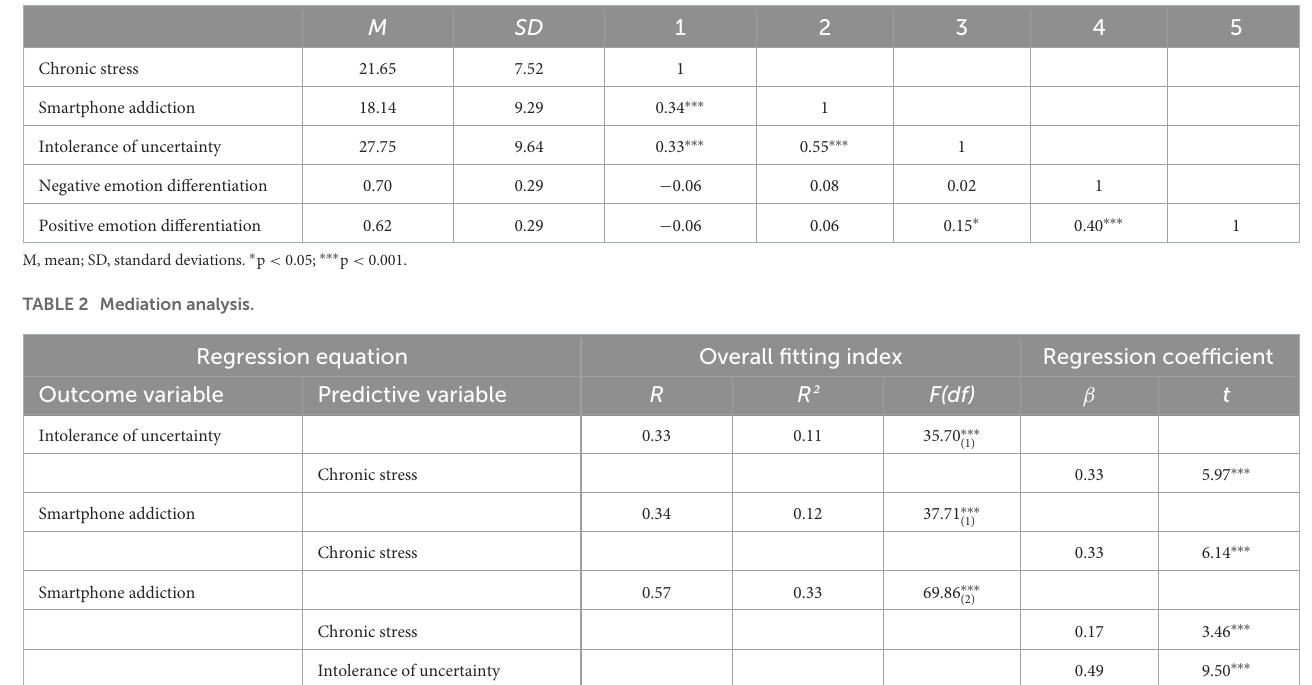
TABLE 1 Descriptive statistics and correlations of all variables.